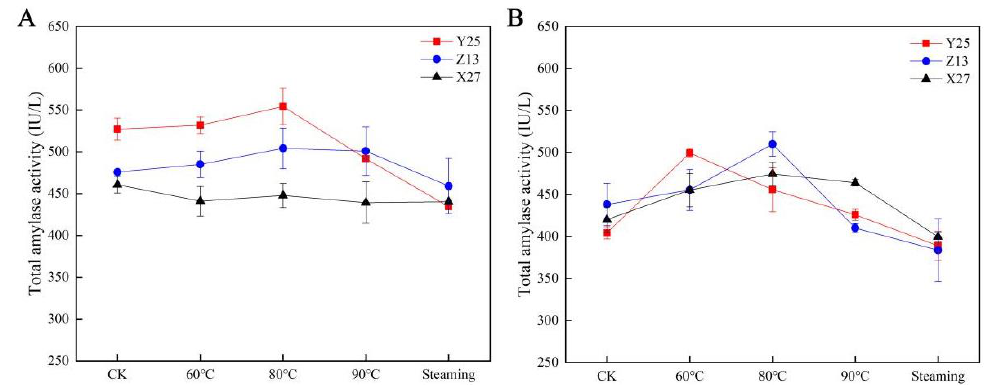
Figure 4. Total amylase activity of sweetpotato in two growth stages. Total amylase activity in sweetpotato between ( A ) 90 and ( B ) 130 days, respectively. The SE of three biological repetitions is shown as an error bar.